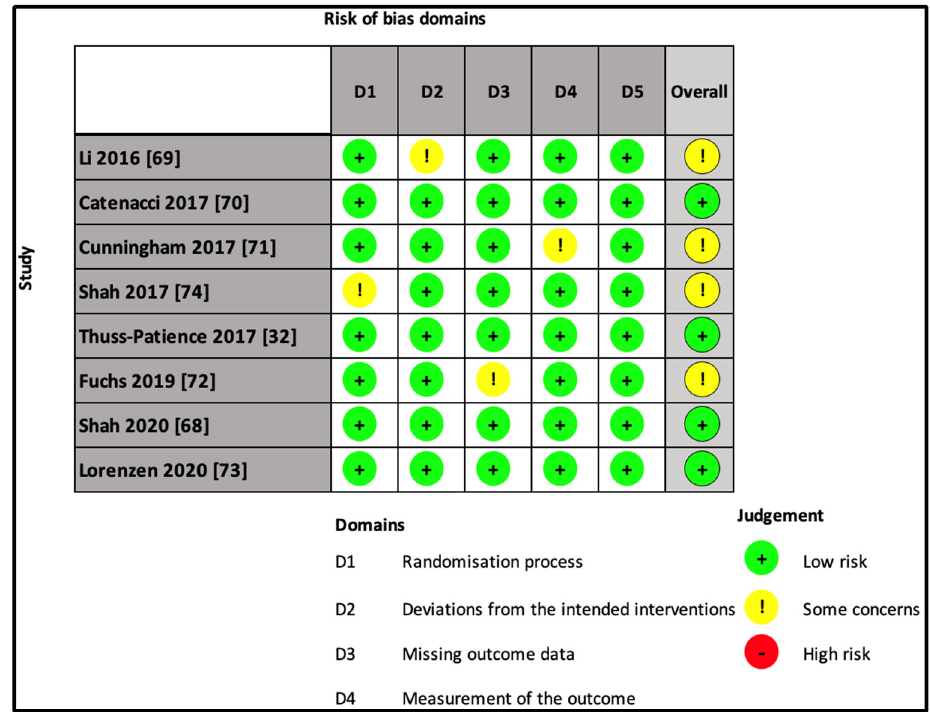
Figure 3. Risk of bias. To assess the risk of bias of each included study, the revised version of the Cochrane tool (RoB 2) was employed. The RoB 2 tool is structured into domains through which bias might be introduced into the result. These domains were identified based on both empirical evidence and theoretical considerations.